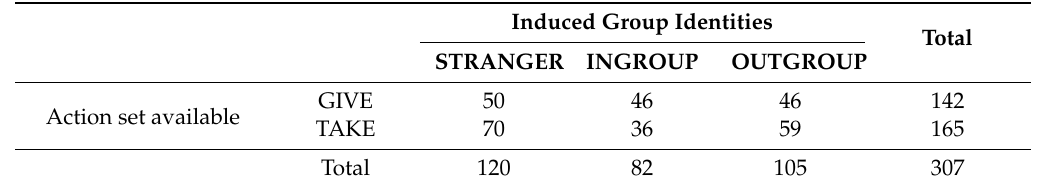
Table 1. Number of observations in